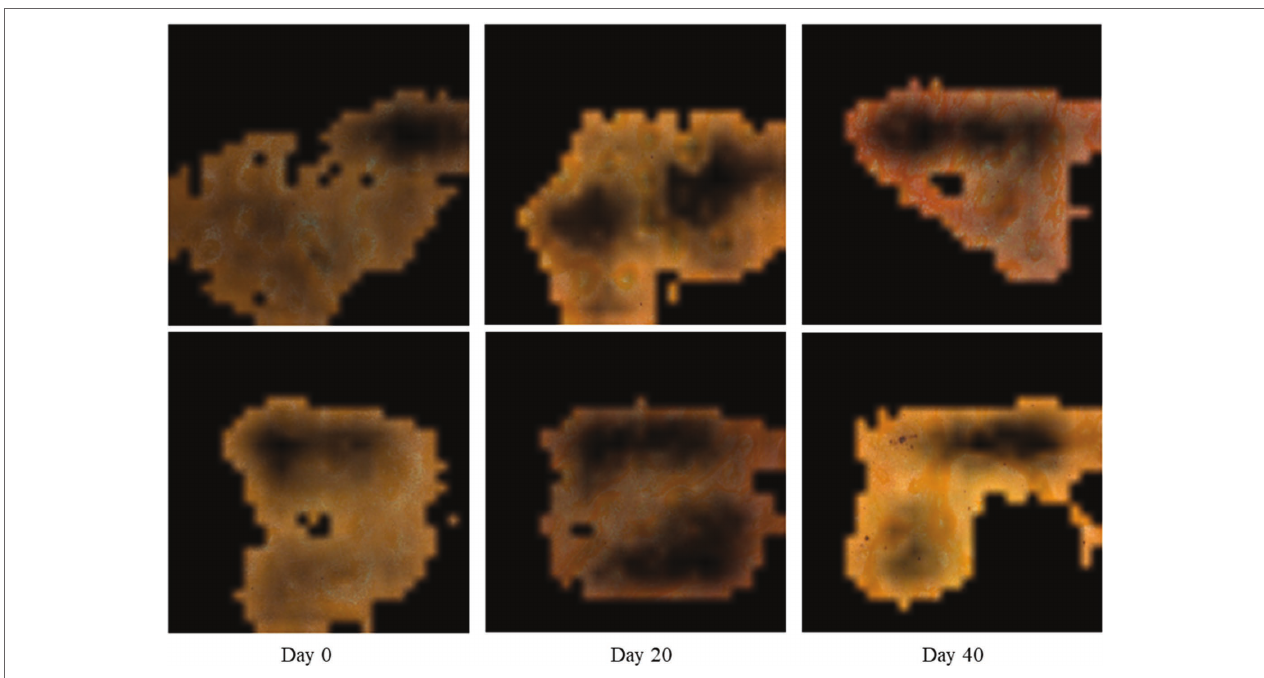
FIGURE 7 | Feature visualization results of the deep learning-based model in different storage